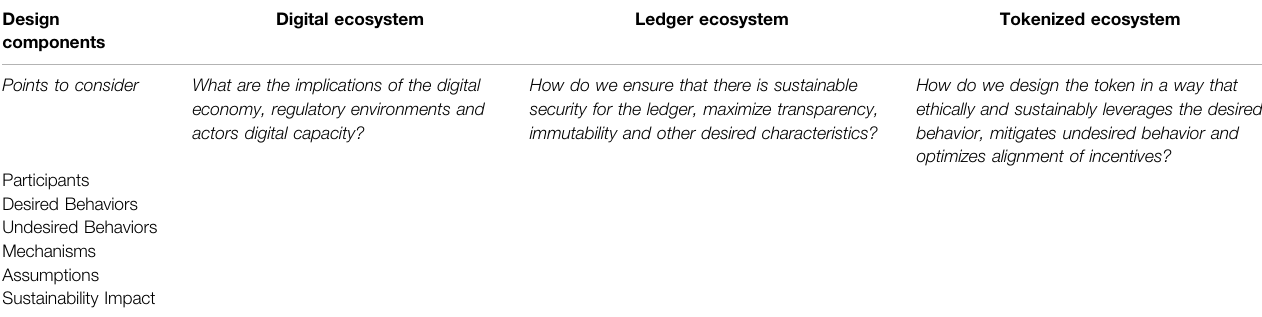
TABLE 1 | Sustainability Matrix